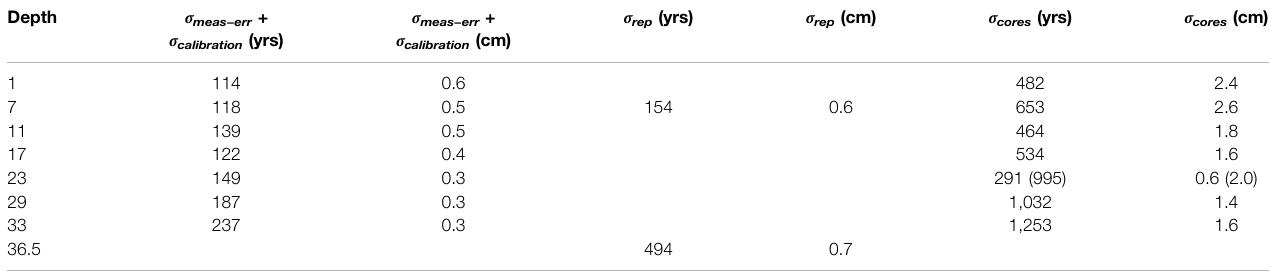
TABLE 4 | Contributions to age and depth uncertainty from different error terms. The error terms are described and illustrated in Section 3.5 . The error from the standard deviation across all large-volume bulk samples ( σ cores ) is the remaining uncertainty after accounting for σ meas − err , σ calibration and an interpolated estimate of σ rep . For the small-volume bulk samples, σ small − volume is mentioned in brackets at 23 cm depth. The depth estimates are derived by scaling the age estimates with the sediment accumulation rate output from the BACON model.